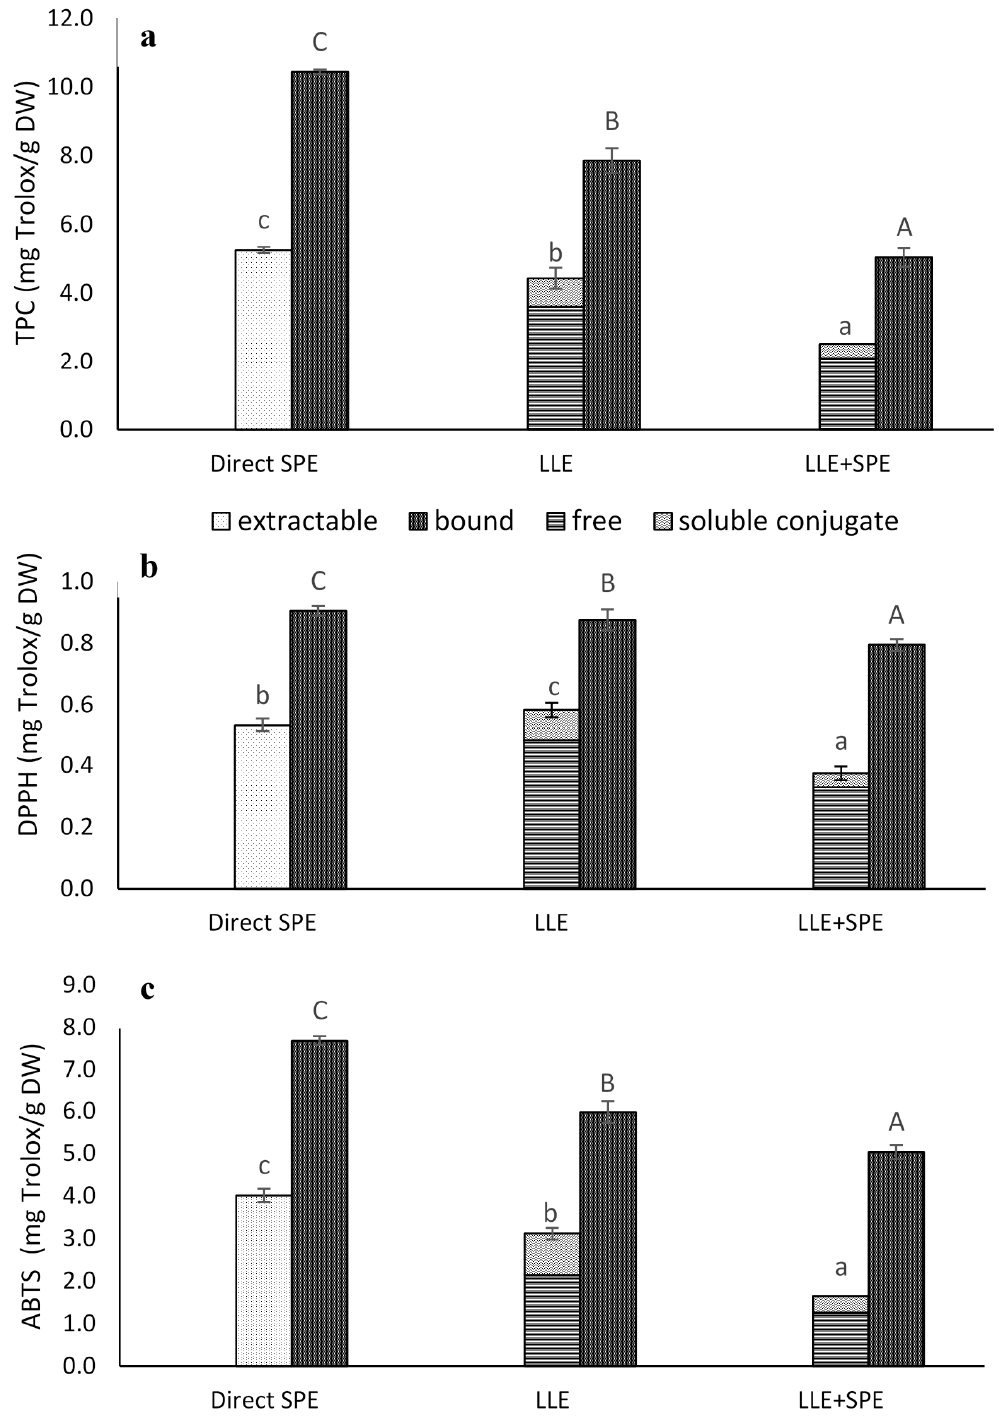
Figure 3. Total phenolics content (TPC) ( a ) and antioxidant activities (DPPH • , ABTS • + scavenging activities) ( b , c ) from the extractions of the germinated spelt ( Triticum spelta ) seeds, as the extractable and bound phenolics from direct solid-phase extraction (SPE), and for the free, soluble conjugate and bound phenolics from the liquid-liquid extraction without (LLE) and with SPE (LLE + SPE) purification. Data are means ± SD. Different letters within the same fractions as extractable and (free + soluble conjugate) or bound indicate significant differences ( p < 0.05; Duncan’s multiple range tests).